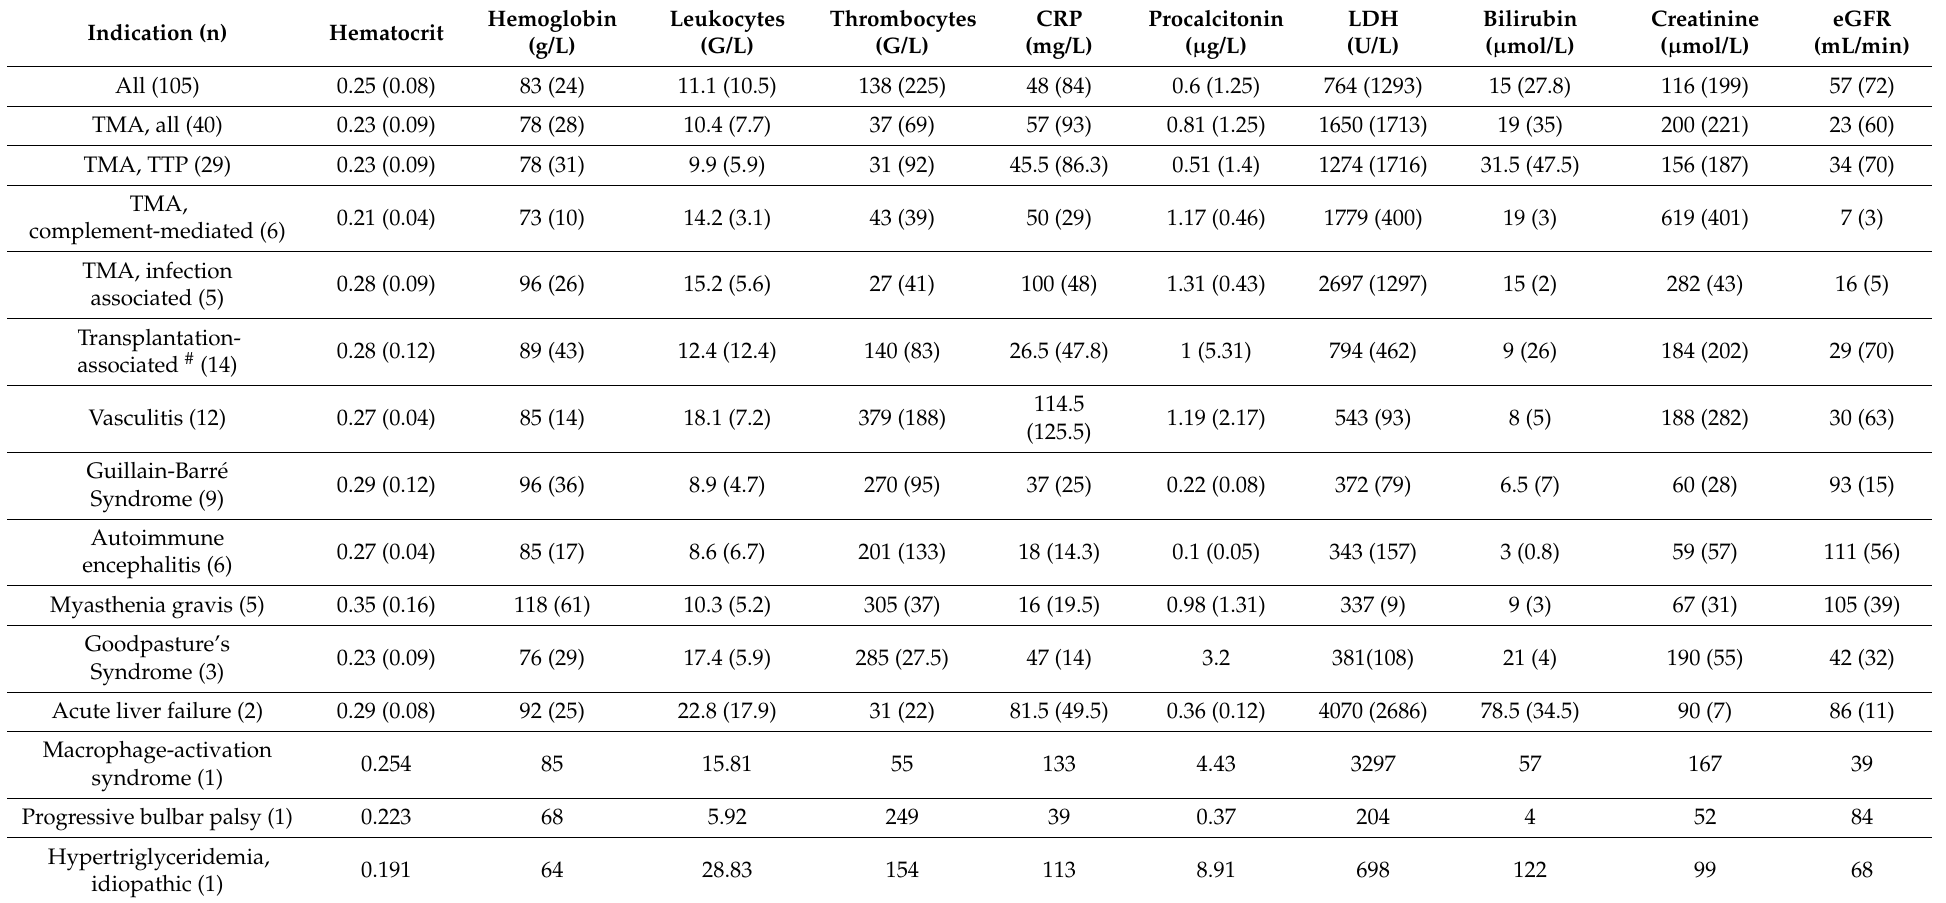
Table 3. Laboratory parameters before initiation of TPE per indication . Data are presented as median and interquartile range. Abbreviations: TTP—Thrombotic thrombocytopenic purpura, TMA—Thrombotic microangiopathy, TPE—therapeutic plasma exchange, eGFR—estimated glomerular filtration rate. #